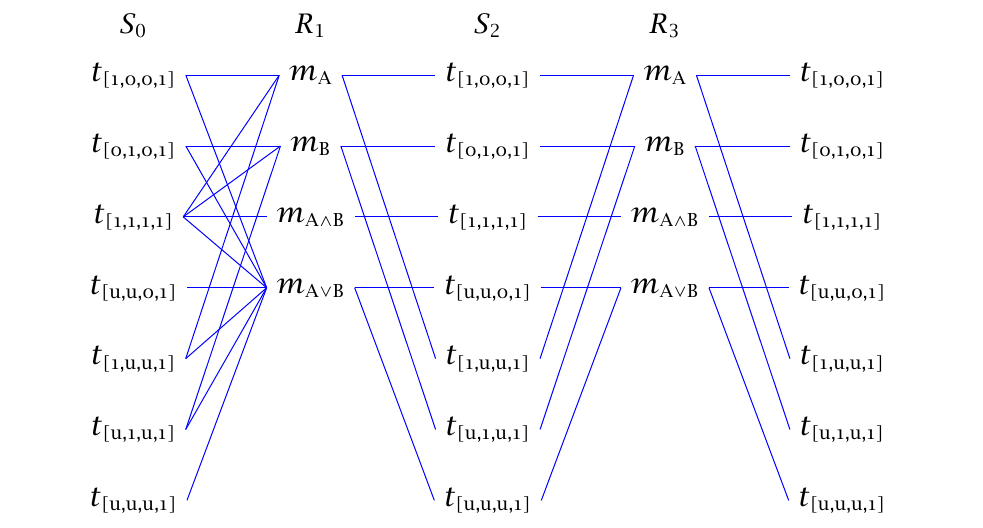
Figure 14 Predictions for the interpretation of “ A or B ” with